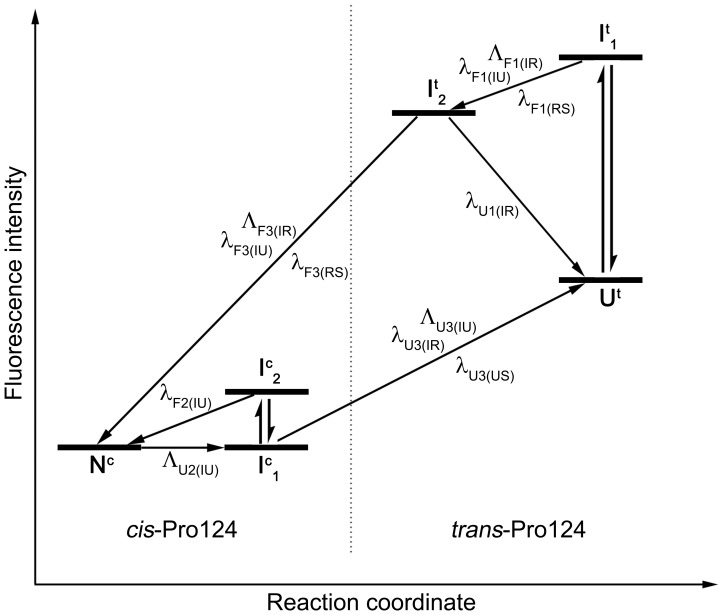
Working scheme for CMPK folding- and unfolding pathways.Folding scheme for folding and refolding of CMPK, omitting refolding from the Uc species. The x-axis represents the reaction coordinate, while the y-axis corresponds to fluorescence intensity of Trp31 during refolding of wildtype CMPK. Each horizontal line indicates a macroscopic species, as observed in the folding experiments. The native (Nc) and unfolded state with trans-Pro124 (Ut) are indicated separately. Vertical double arrows represent burst-phases. Arrows heading left indicate folding transitions, arrows heading right unfolding transitions. The transition rate constants corresponding to each arrow are positioned next to it. The dotted line indicates the energy barrier associated with the slow folding and unfolding process, separating the cis- from the trans- Pro124 species.